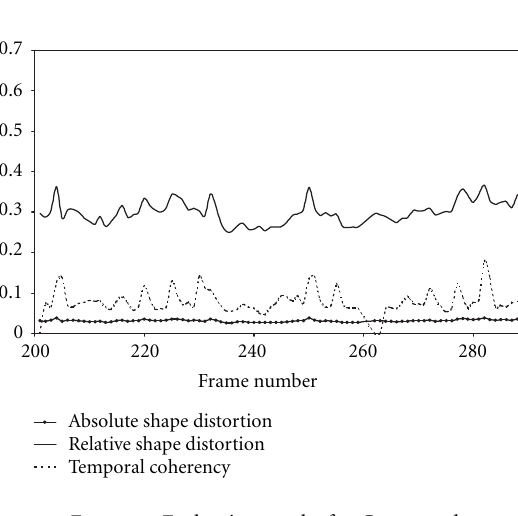
Figure 7: Evaluation results for Coastguard